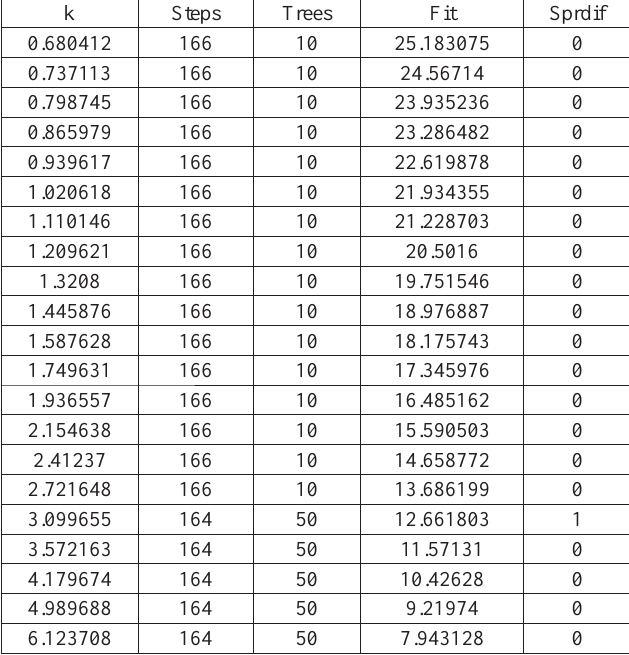
Table 6. Results from the extended implied weighting analysis under different values of k (concavity constant). “Steps” indicate the number of steps of MPTs obtained, “Trees” indicate the number of MPTs ob- tained, “Fit” indicates the fit value for the MPTs and “Sprdif” indicates the subtree pruning regrafting distances between successive k values used in the analysis.